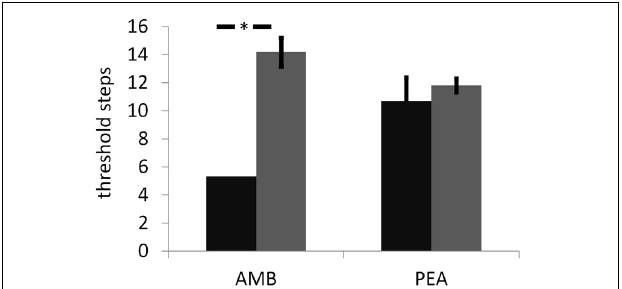
FIGURE 1 | Results for the threshold assessment (in log 2 of the stock solution) for ambroxan (AMB) and the control odor phenyl ethyl alcohol (PEA) and in both groups of subjects (black bar: subjects insensitive to ambroxan; gray bar: subjects sensitive to ambroxan). Error bars indicate standard errors. Asterisk indicates a significant difference between subject groups for AMB; no difference was observed for PEA. Table 1 | Subjective evaluation of odors in the scanner.